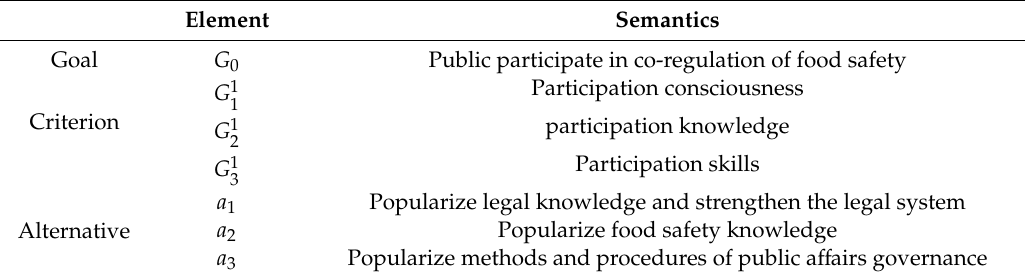
Figure 3. The public participate in co-regulation of food safety. Table 2. Description of elements in Figure